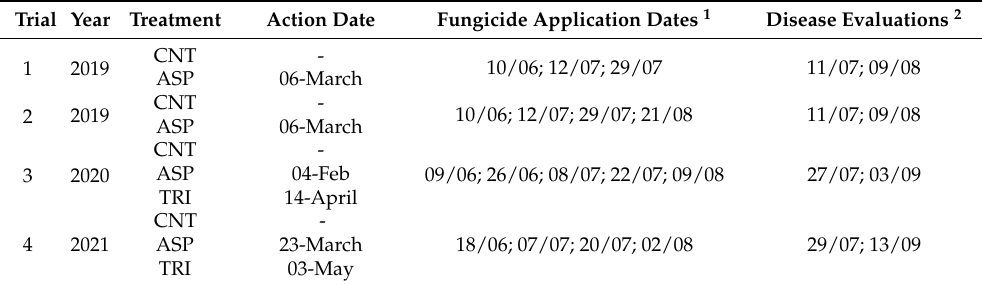
Table 2. Treatments performed in orchard trials for evaluating the effect of different sanitation methods aimed at controlling Alternaria fruit spot of apple. Treatments included are no inoculum- management strategy (CNT) and aspiration strategy